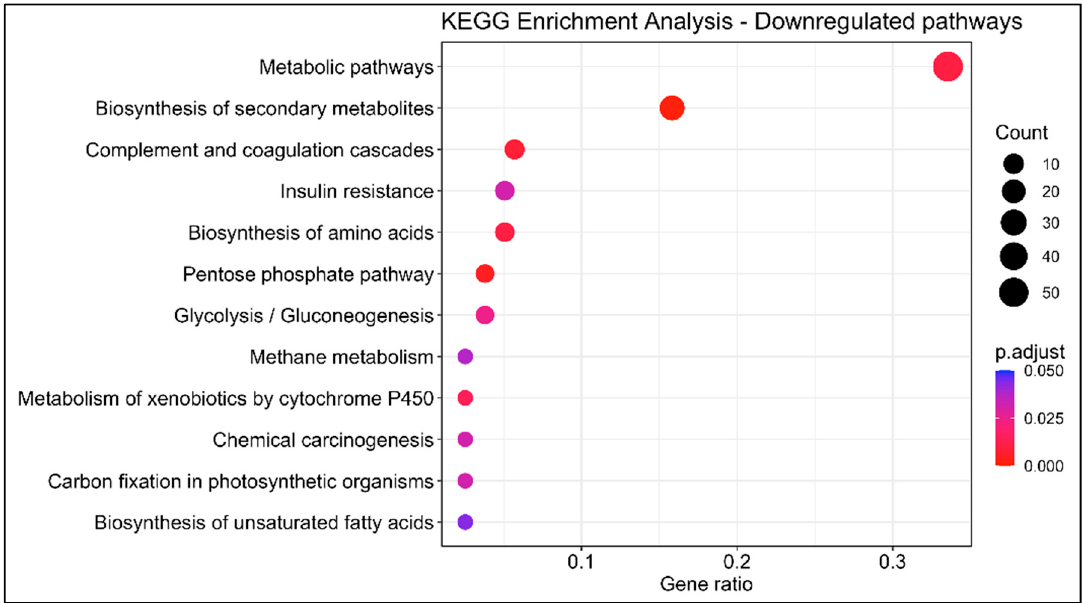
Figure 8. KEGG enrichment analysis of differentially downregulated genes between livers of imma- ture ( n = 3) and mature ( n = 3) females. y -axis indicates the pathway description; x -axis indicates the gene ratio. The size of the dot is based on gene count, and the color of the dot shows the GO term's enrichment significance ( p -adjust < 0.05).